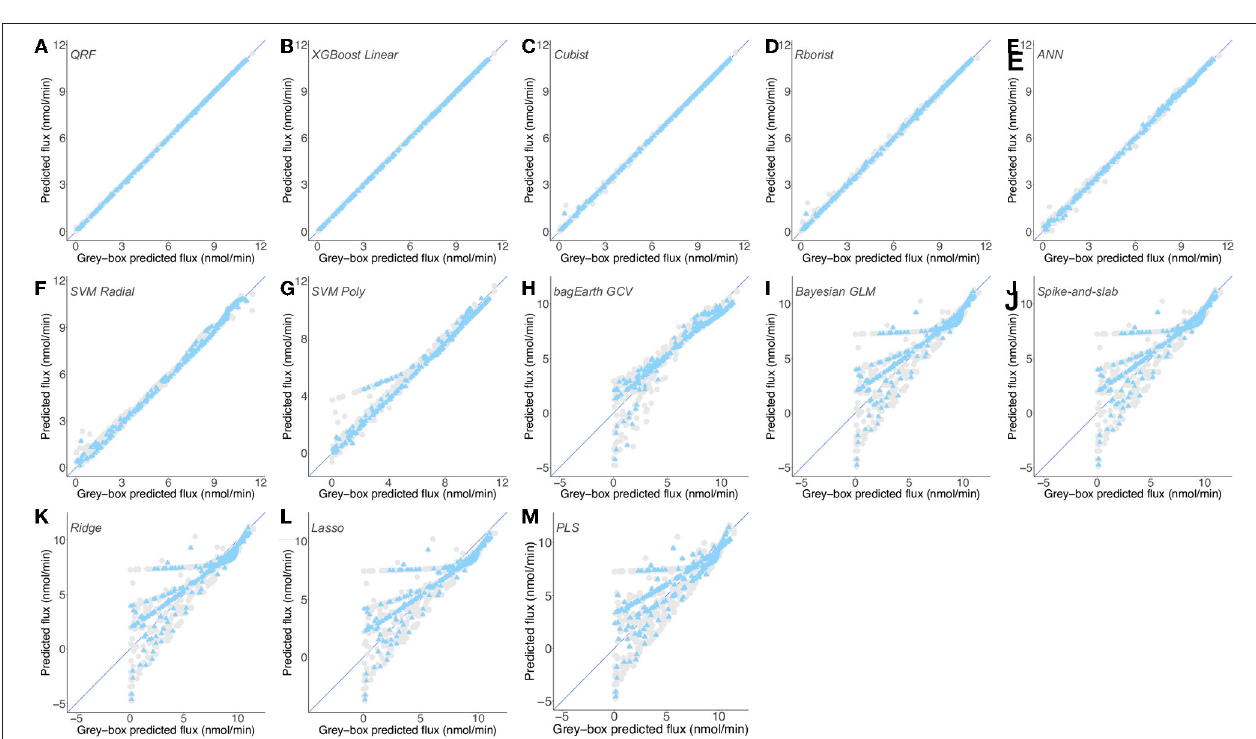
FIGURE 7 | Predictions of gray-box predicted flux by different predictive models for Dataset 2 . (A–M) Flux from the second dataset ( Supplementary Table 8 ) predicted by the QRF (A) , XGBoost Linear (B) , Cubist (C) , Rborist (D) , ANN (E) , SVM Radial (F) , SVM Poly (G) , bagEarth GCV (H) , Bayesian GLM (I) , Spike-and-slab (J) , Ridge (K) , Lasso (L) and PLS (M) models. Gray circles: training set, and blue triangles: test set. See Table 3 for the statistical measurements of each model.